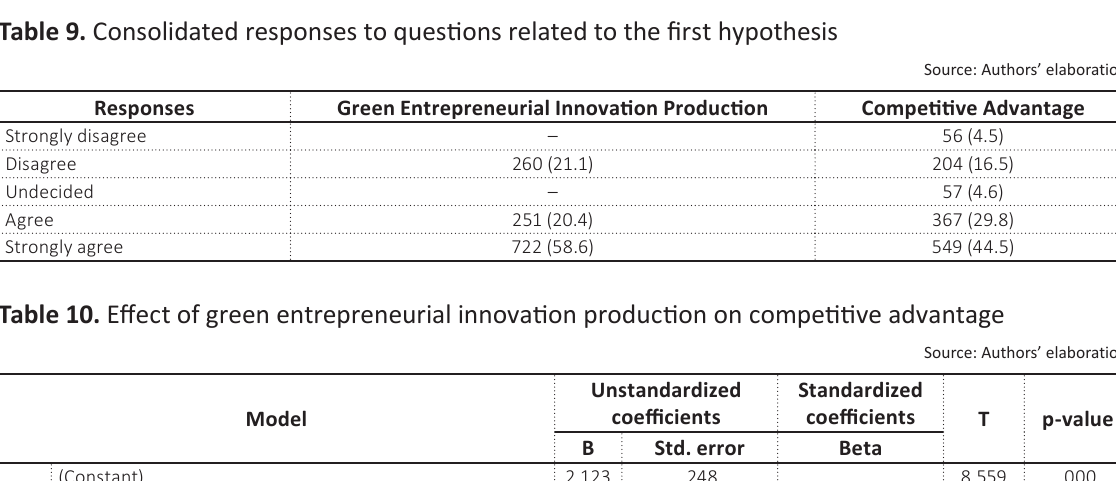
Source: Authors’ elaboration.